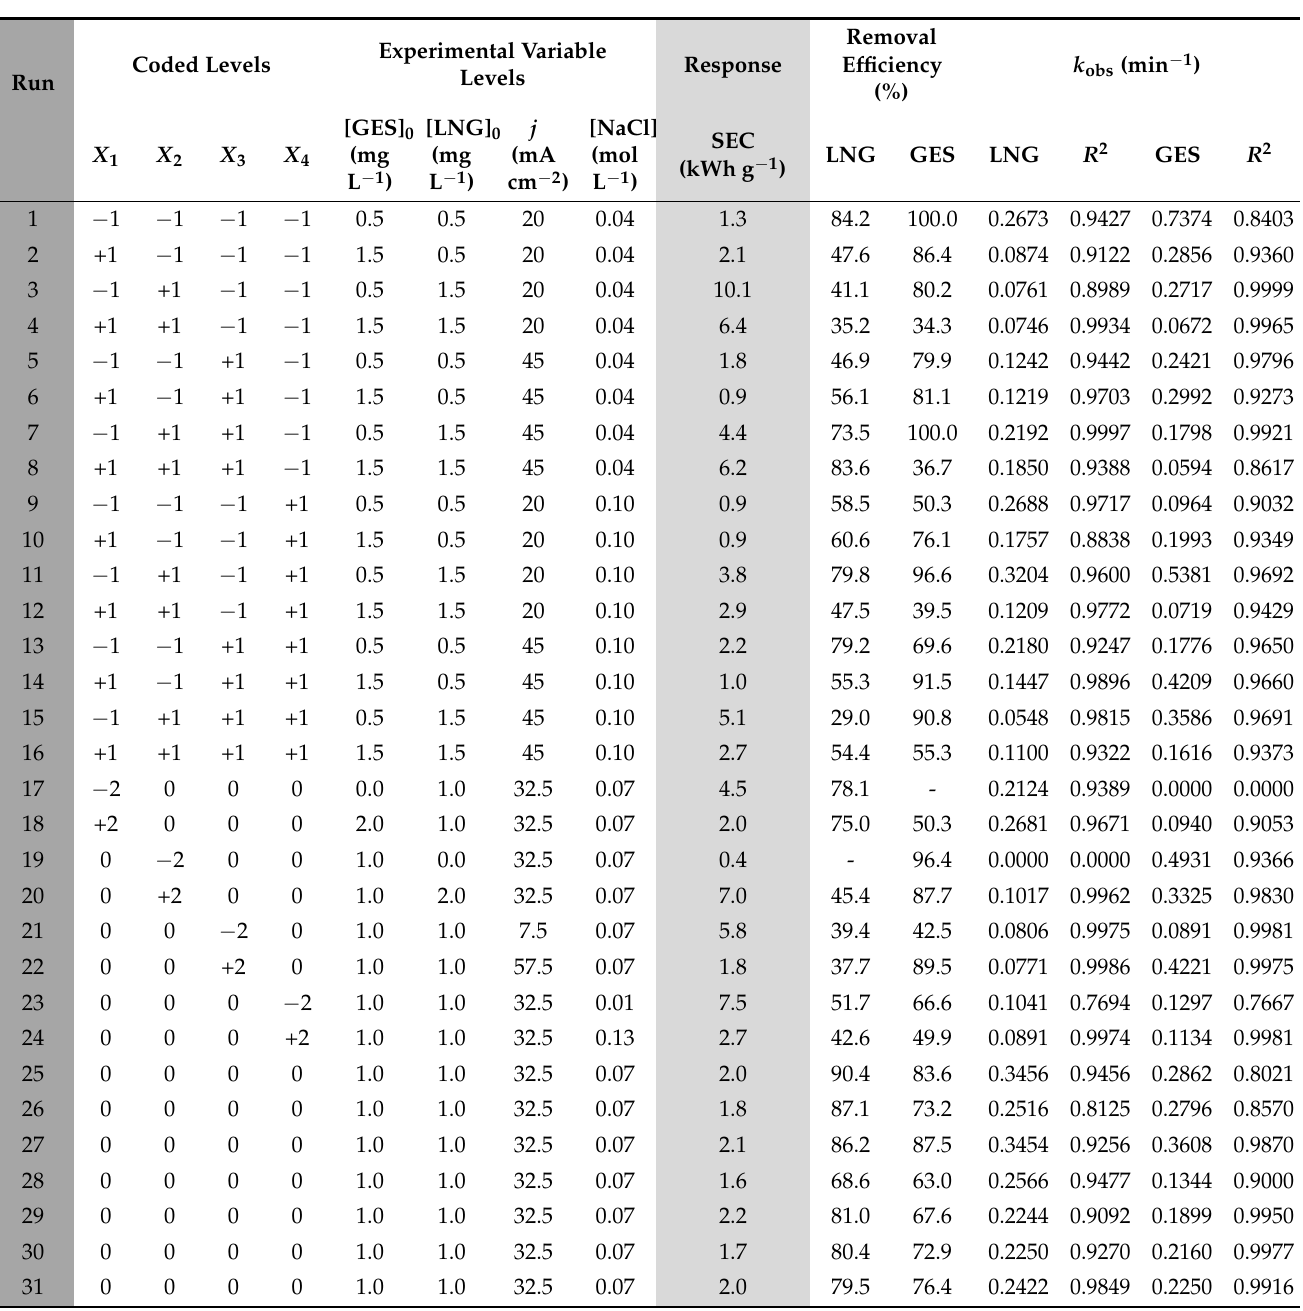
Table 4. CCD matrix and variable levels used to study the influence of operating parameters on the anodic oxidation of levonorgestrel (LNG) and gestodene (GES), response variable (SEC) applied in the statistical analysis, and additional observed